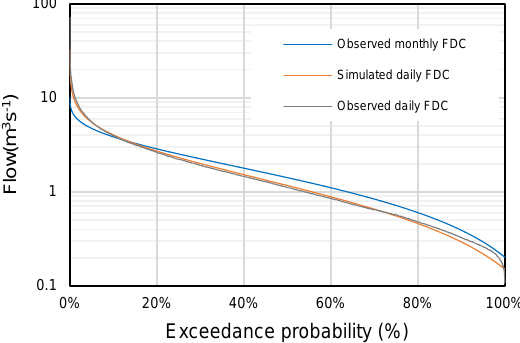
Figure 7. Simulated daily FDC based on monthly FDC.